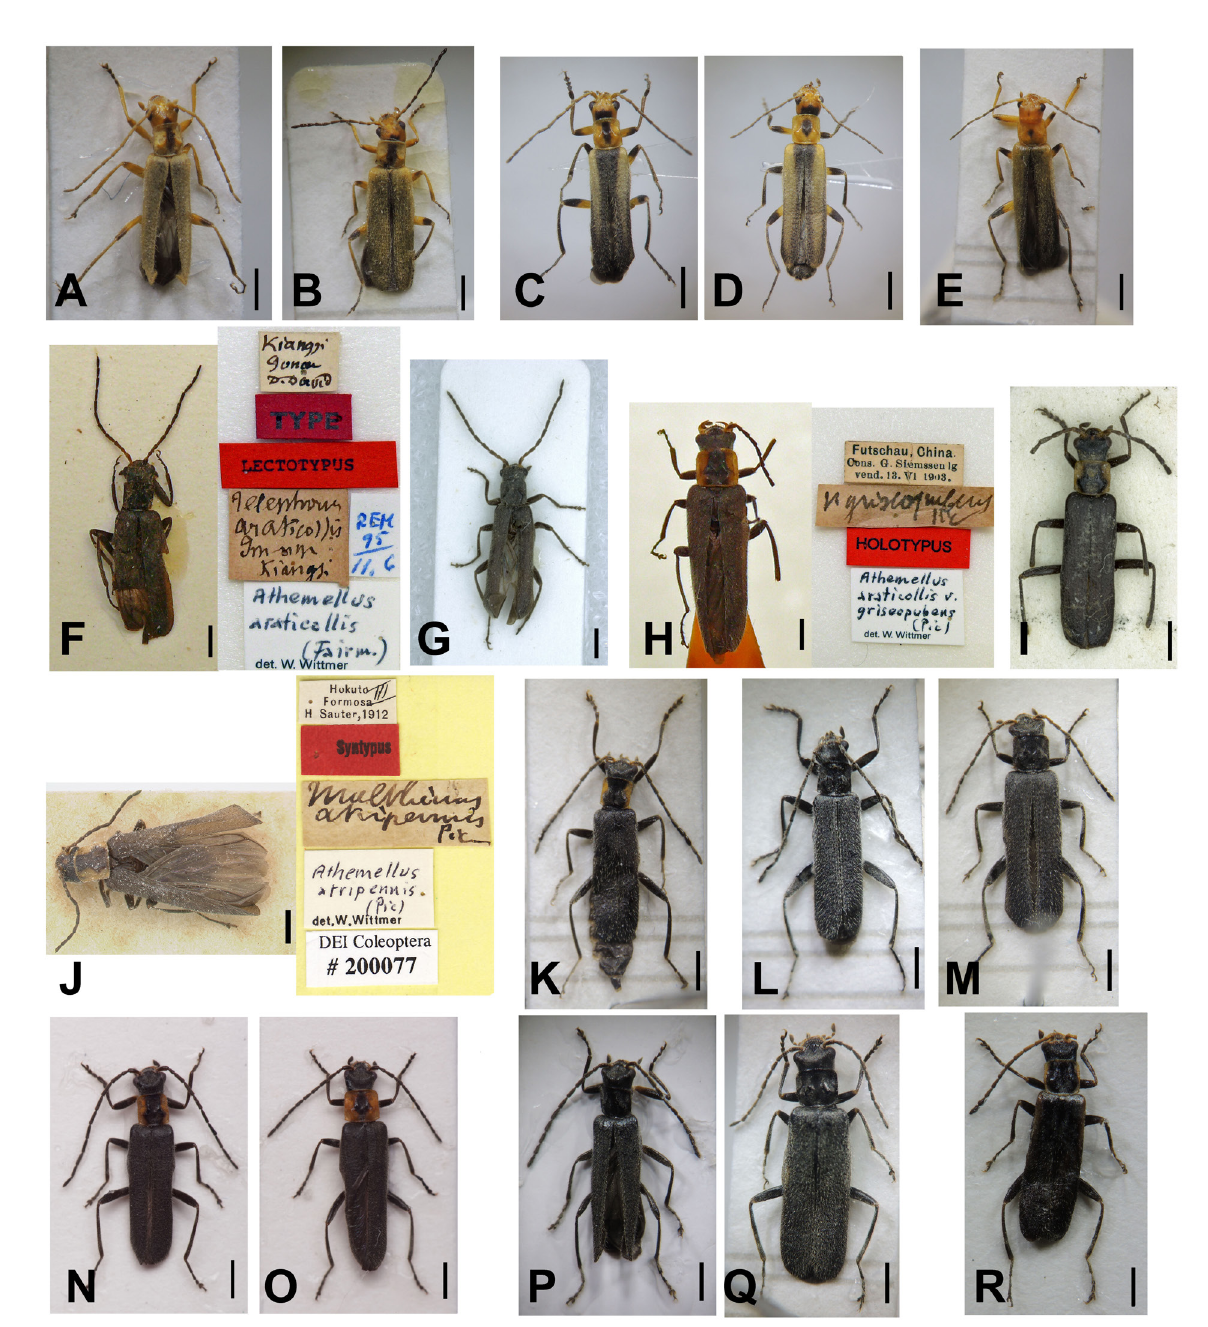
Fig. 2. Habitus, dorsal view. A–B . Lycocerus pictus (Wittmer, 1983). C–E . L. yitingi Hsiao & Okushima sp. nov. F–G . L. araticollis (Fairmaire, 1897). H–I . L. griseopubens (Pic, 1928). J–M . L. nigripennis (Pic, 1938). N–O . L. aurantiacus Hsiao & Okushima sp. nov. P–Q . L. evangelium Hsiao & Okushima sp. nov. R . L. kintaroi Hsiao & Okushima sp. nov. C, F, H, J, N, P, R. Name-bearing types. D, O, Q. Paratypes. A–B, E, G, I, K–M. Non-type specimens. A, C, F–G, I, K–L, N, P, R. Male. B, D–E, H, J, M, O, Q. Female. Scale bars: 1.0